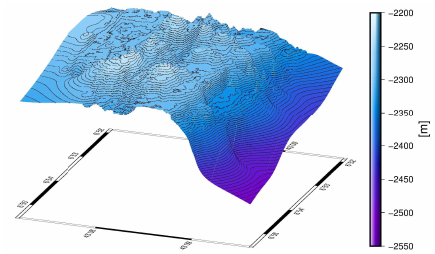
Figure 4: Perspective view of the bathymetric surface. Width and length of the area are worth about 6 km.